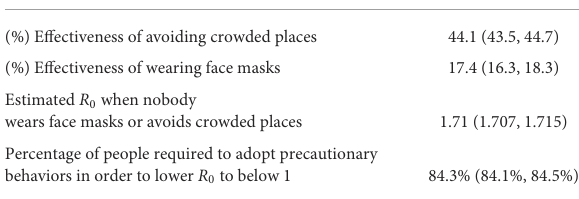
TABLE 1 Impacts of precautionary behaviors in influenza control and transmissibility from our model.